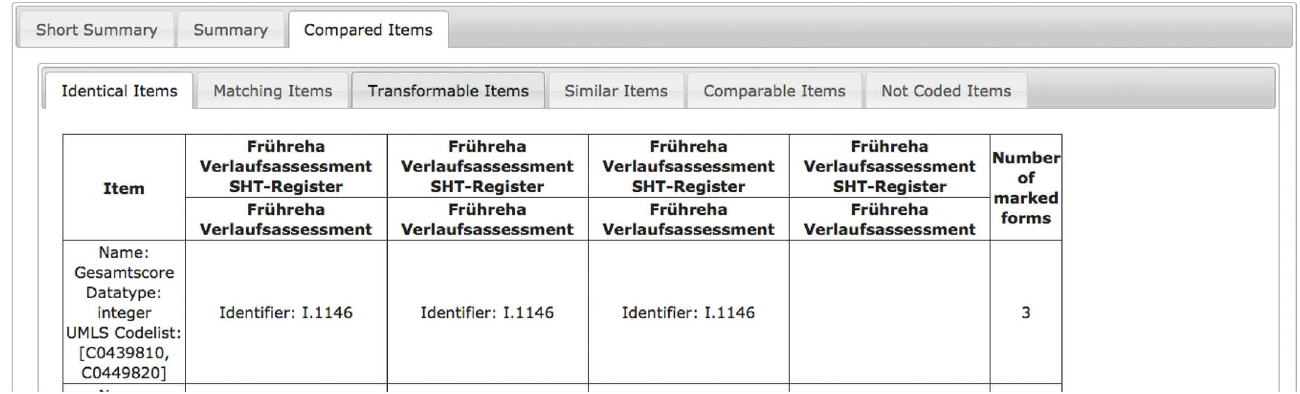
Fig 9. Comparison of 4 versions of a form regarding item “Gesamtscore” (eng. total score). It is availablein identicalmanner in versions 1,2 and